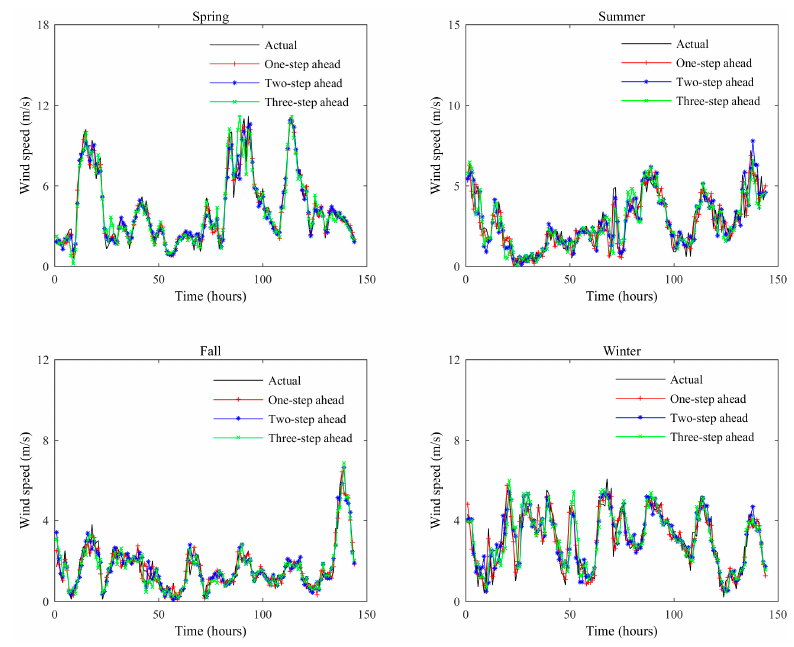
Figure 10. Multi ‐ step ahead prediction results of original wind speed in four cases. Figure 10. Multi-step ahead prediction results of original wind speed in four cases.